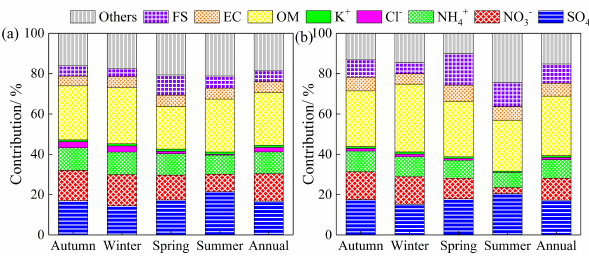
Figure 2. Seasonal and annual contributions of individual chemical components to PM 2 . 5 at CD (a) and CQ (b)